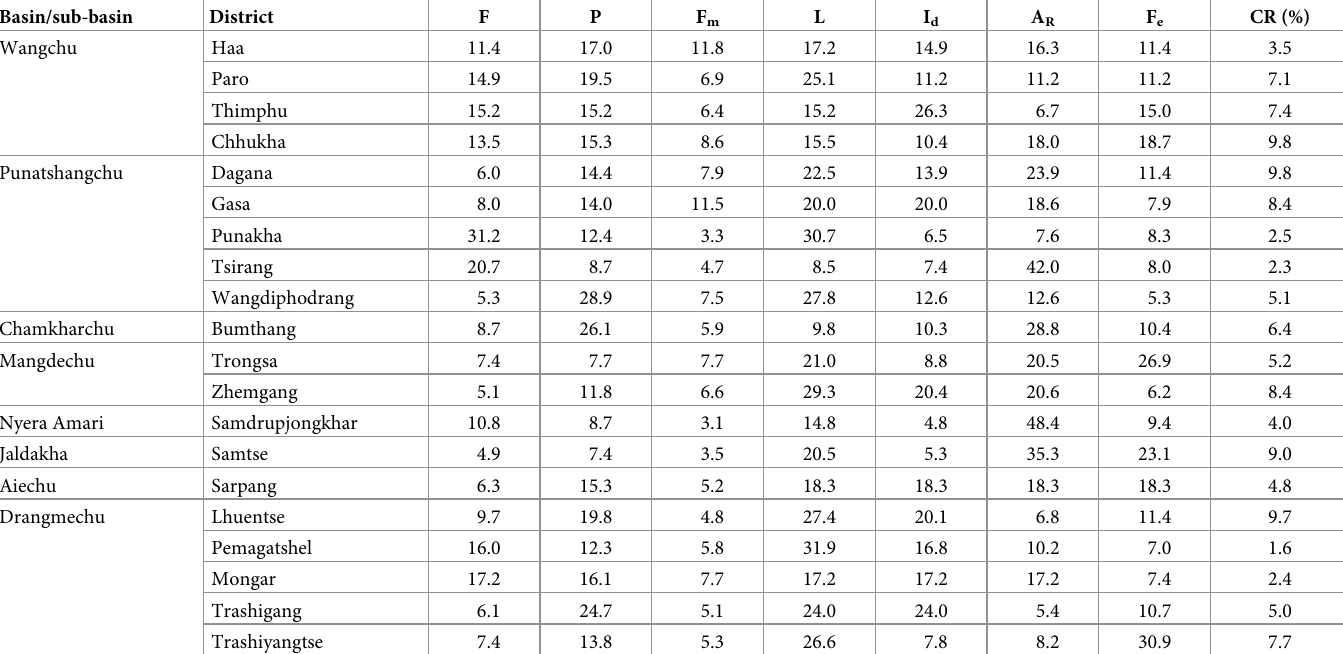
Table 7. District-level priority rankings of FV indicators (%) and corresponding CR values. Basin/sub-basin District